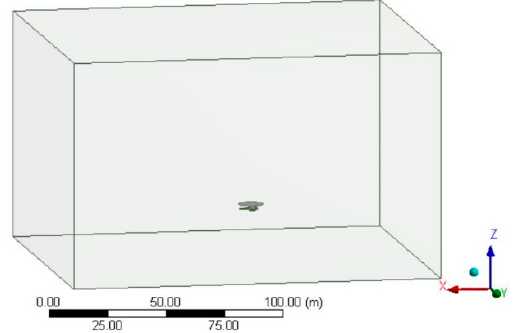
Figure 4. Computational domain of the helicopter.